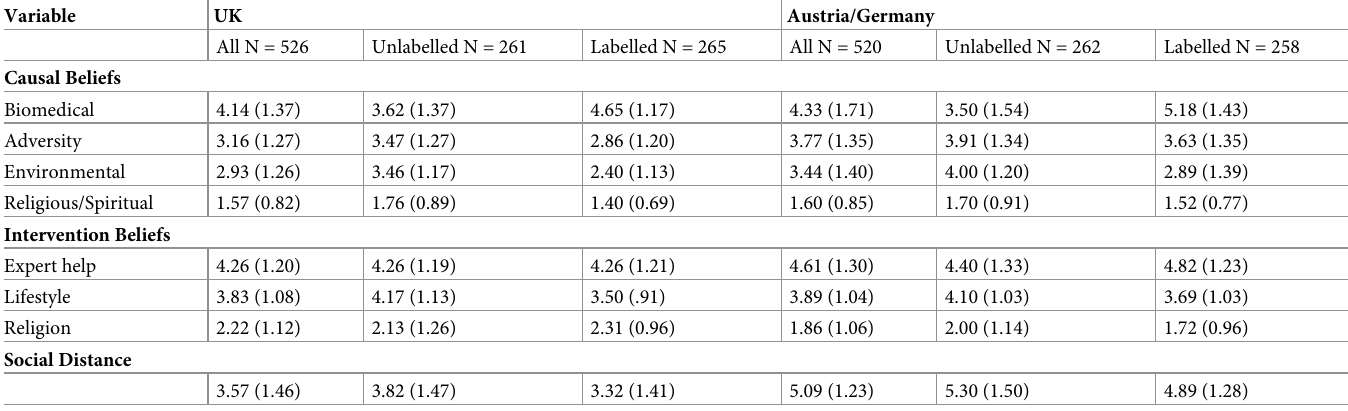
Table 4. Causal beliefs, intervention beliefs and social distance by country and condition: Means (standard deviations).